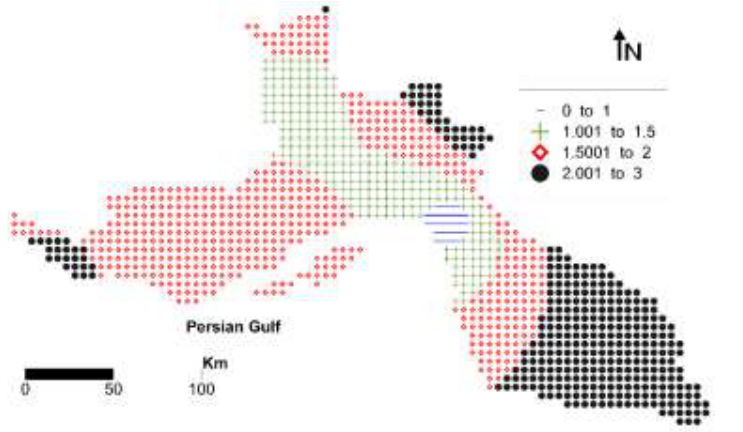
Figure 2 . The zoning of wind magnitude in Hormozgan province Table 3 . The statistical characteristics of wind power with 10 m rotor radius Region 1 Region 2 Region 3 Region 4 Area % 40.8 31.5 17.7 10 mean 1645 3423 6492 8824 Average deviation 467 556 751 417